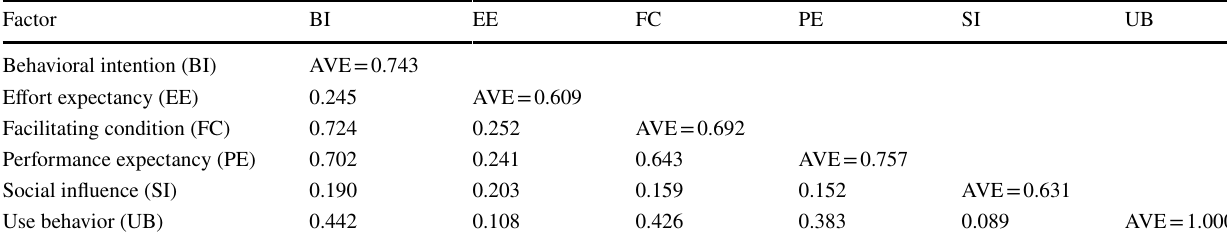
Table 4 Fornell and Larcker